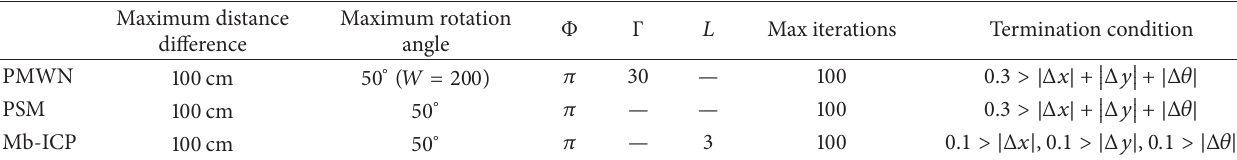
Table 1: Primary experiment parameters.